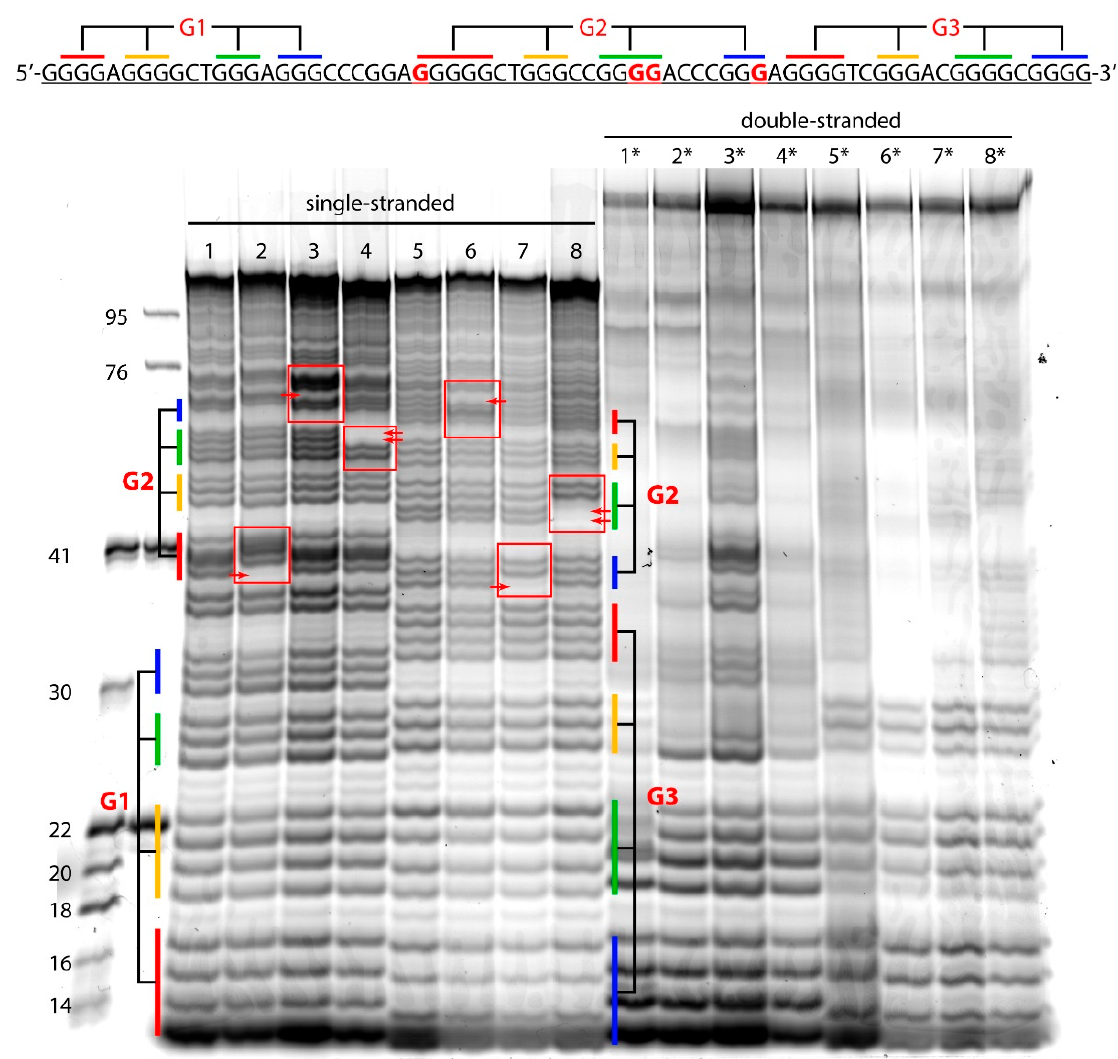
Figure 5. DMS ‐ induced chemical cleavage patterns of single ‐ stranded (lanes 1–8) and double ‐ stranded (lanes 1*–8*) DNA models labeled with the TAMRA fluorophore at the 3 ′ ends (lanes 1–4 and 1*–4*) and 5 ′ ends (5–8 and 5*–8*). Lanes: 1—WT ‐ 5 ′ , 2—G228A ‐ 5 ′ , 3—G250A ‐ 5 ′ , 4—G242,243A ‐ 5 ′ , 5—WT ‐ 3 ′ , 6—G228A ‐ 3 ′ , 7—G250A ‐ 3 ′ , and 8—G242,243A ‐ 3 ′ . Lanes 1*–8* correspond to double ‐ stranded models formed by 96-nt DNAs shown in the left panel and fully complementary oligonu- cleotides. The hTERT promoter sequences corresponding to the G-tracts forming each of the three G4 units (G1, G2, and G3) are color ‐ coded in the electropherogram and in the primary structure shown above. Sites of substituted G residues are highlighted by red frames; low ‐ intensity bands corresponding to G>A substitutions are indicated by red